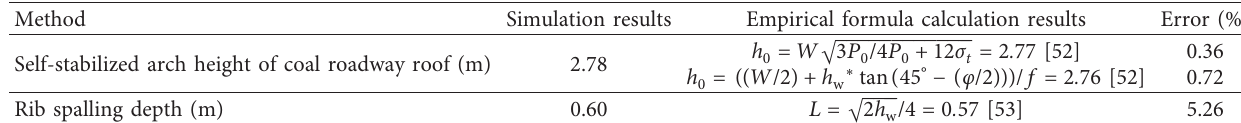
Table 3: Comparison of the results of simulation and empirical calculation of the self-stabilized arch height and rib spalling depth.